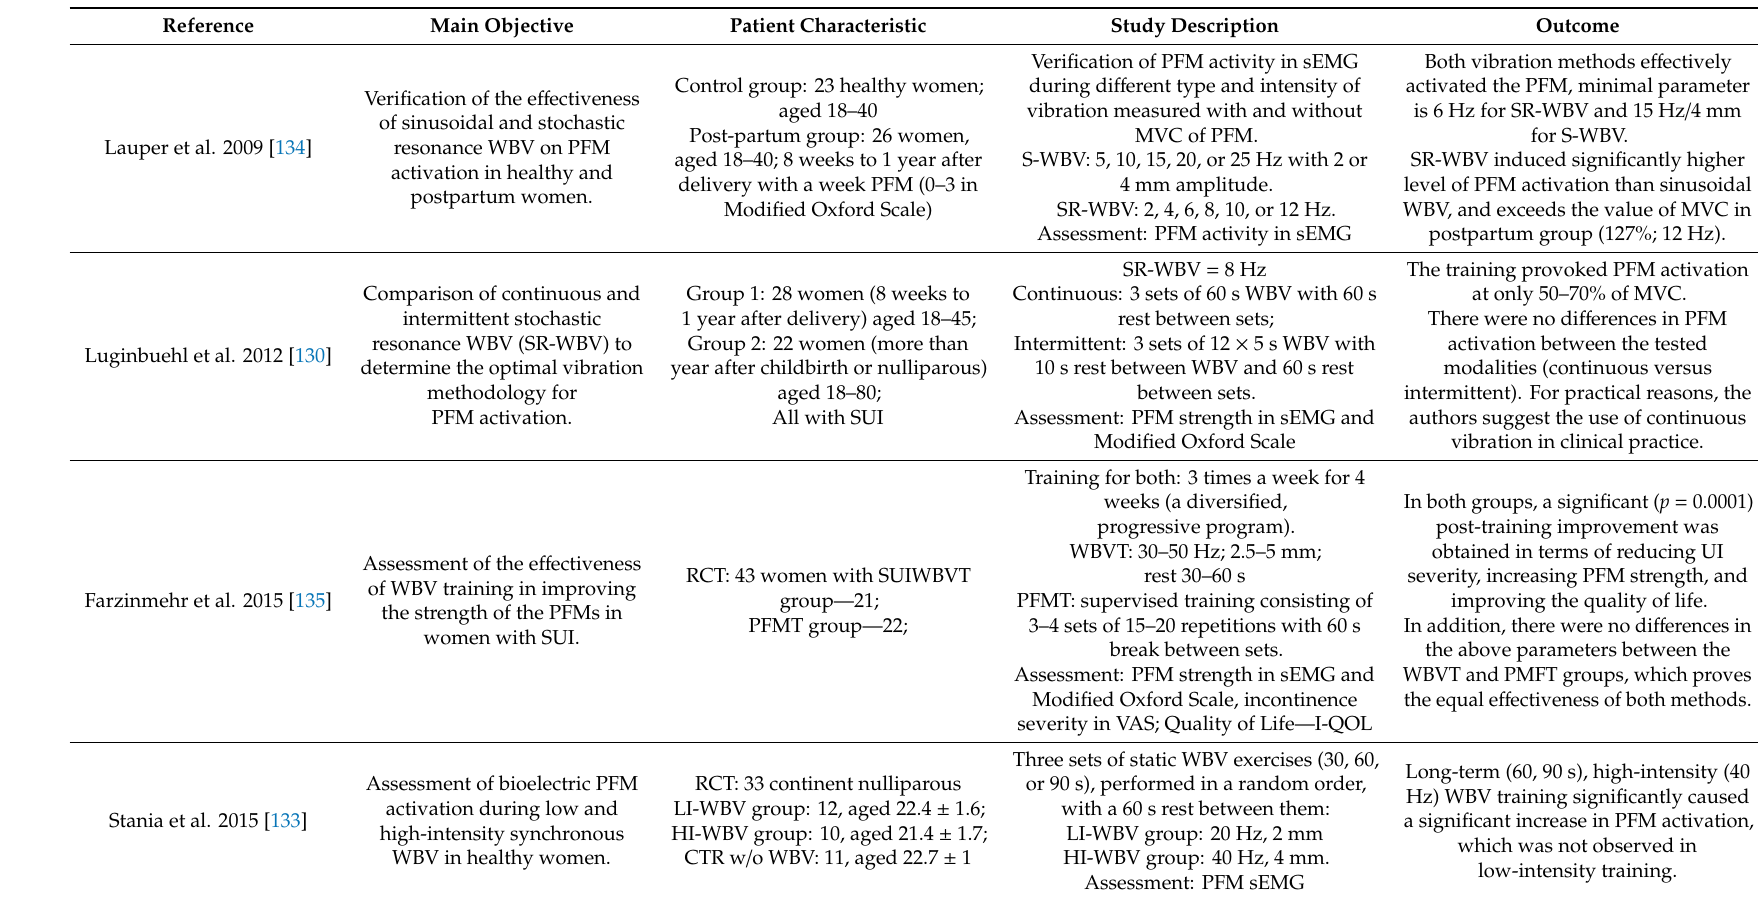
Table 5. Characteristic of selected studies on the e ff ects of whole-body vibration (WBV) training on the pelvic floor muscle (PFM) activity and / or severity of urinary incontinence (UI)